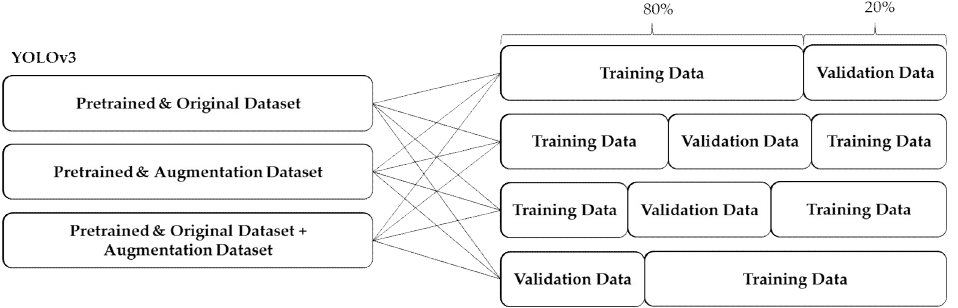
Figure 17. K-fold cross validation methods.